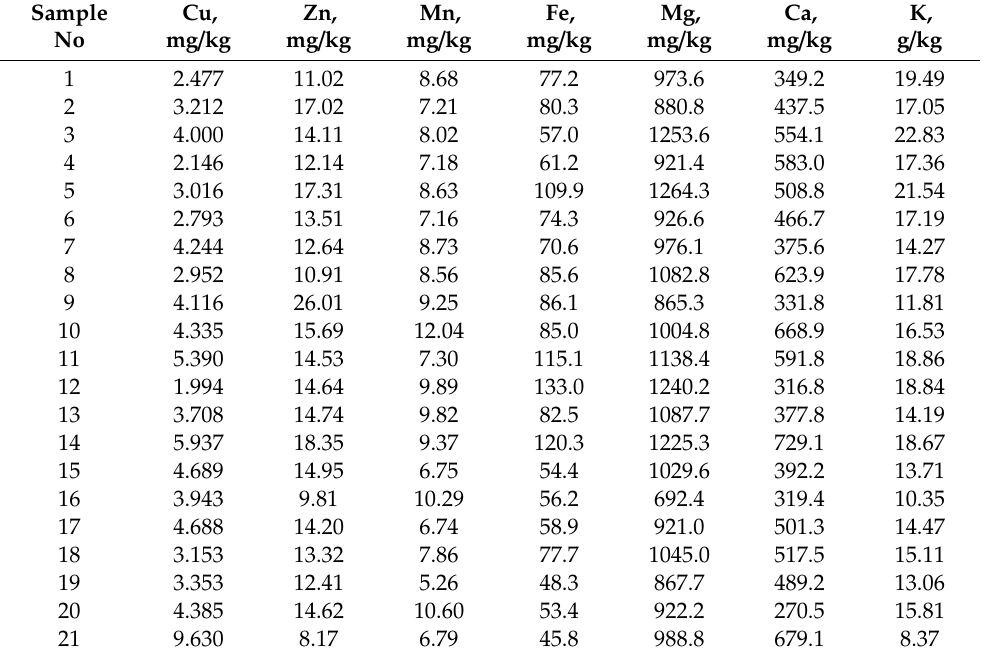
Table 2. Mineral composition of the tubers as determined by atomic absorbance spectroscopy (AAS) per dry weight ( n =